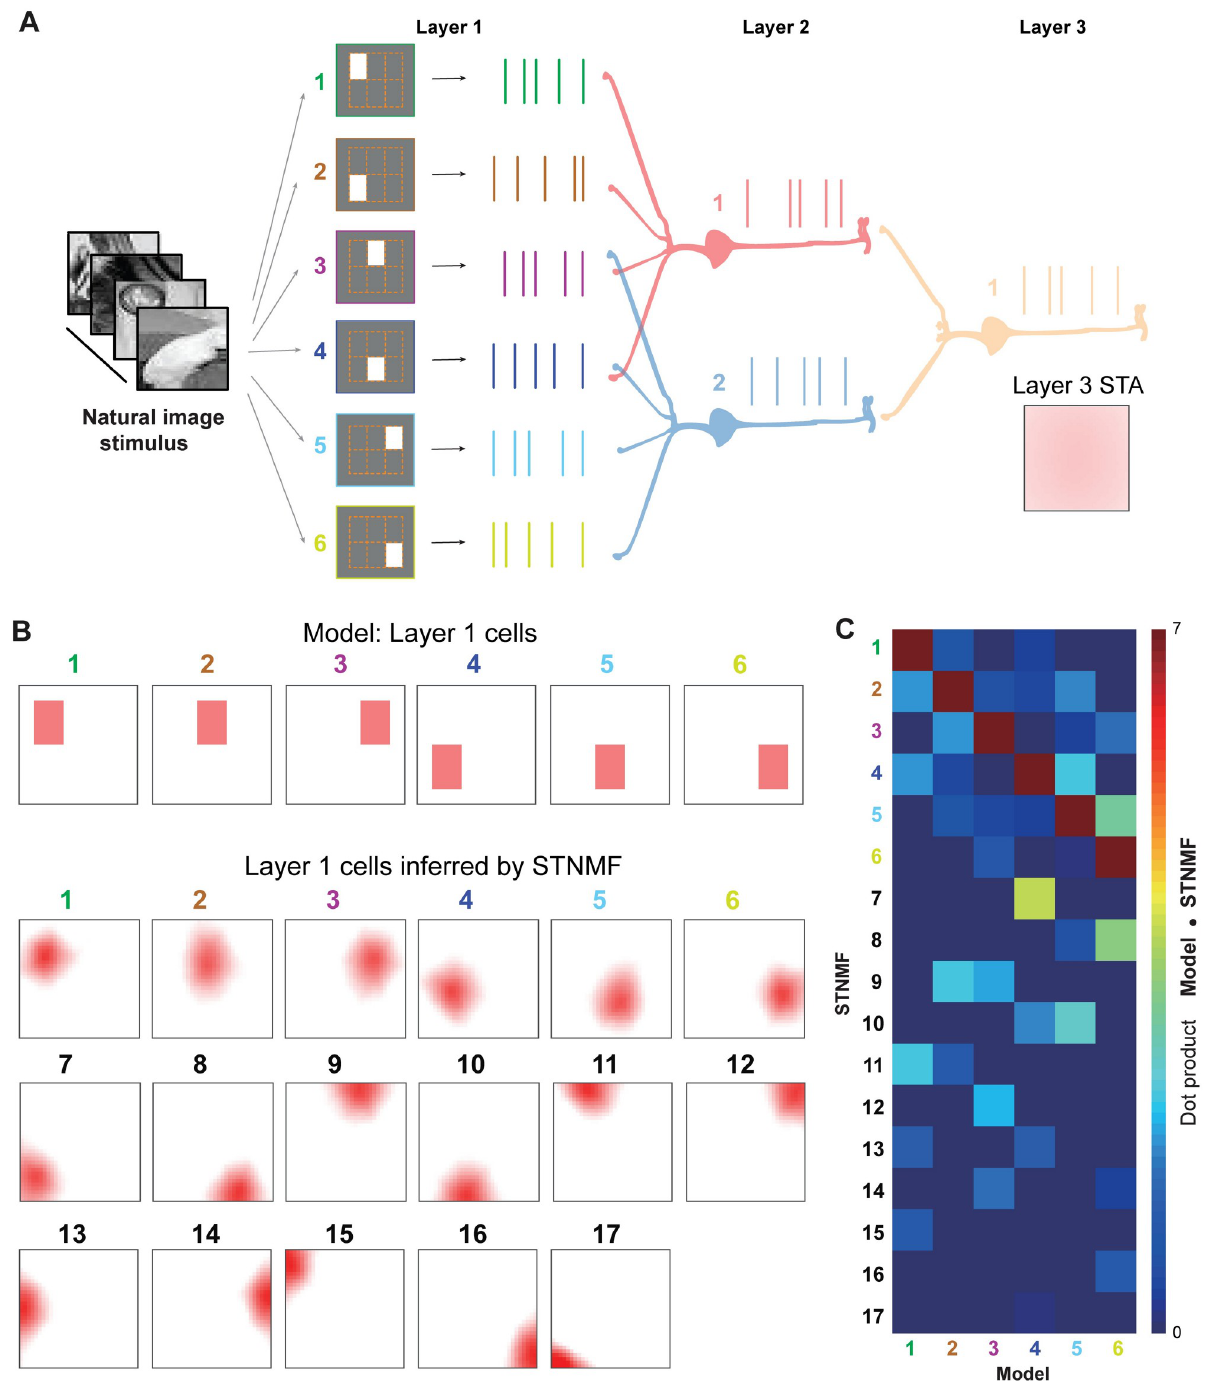
Fig 4. STNMF analysis using natural image stimulus. (A) Similar network model as in Fig 4 but with natural images instead of white noise as stimuli. The STA failed to obtain the RF of Layer 3 cell. (B) Modeled RFs of Layer cells (top) and the STNMF inferred results with 17 subunits (bottom). (C) Dot product matrix of the model RFs and STNMF subunits showing that the first subunits resemble the model cells.